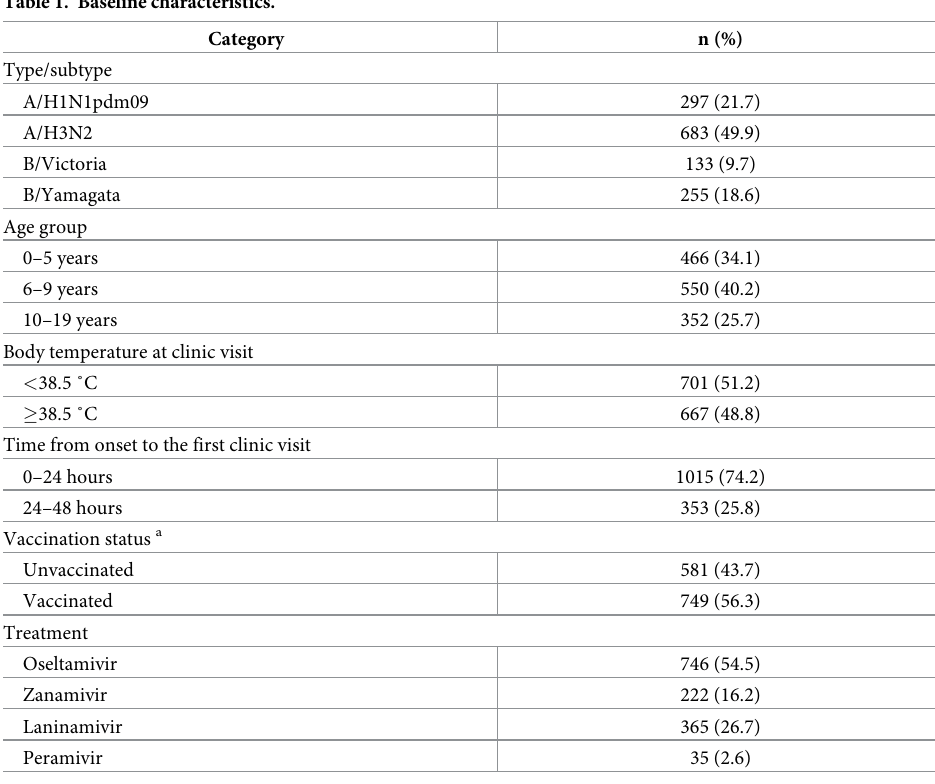
Table 1. Baseline